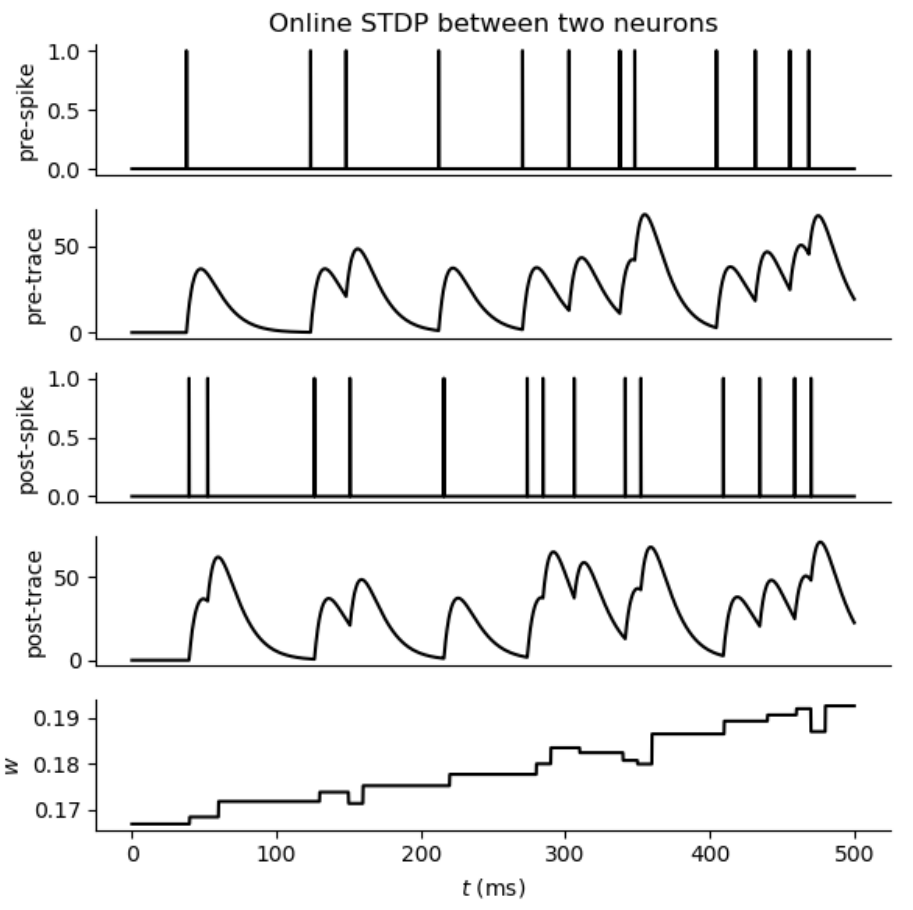
Figure 4. Weight change in two neurons based on STDP learning